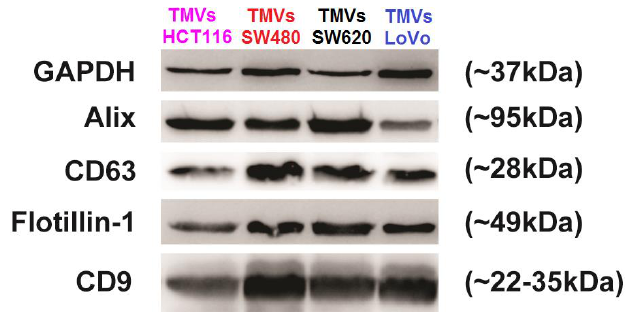
Figure 1. Western blot analysis of GAPDH, Alix, CD63, Flotillin-1, CD9 expression in TMVs collected from HCT116, LoVo, SW480, and SW620 cell lines. A total of 20 µ g of the TMV protein was used for each run. After SDS-PAGE separation and transfer of the proteins onto the polyvinylidene fluoride membranes, the membranes were stained with mouse anti-Alix (3A9), rabbit anti-CD9 (D801A), anti-Flotillin-1 (D2V7J) mAbs, and rabbit polyclonal anti-CD63 Abs. As a loading control, rabbit anti-GAPDH Abs were used. Appropriate secondary Abs: goat anti-mouse and goat anti-rabbit conjugated with horseradish peroxidase, followed by SuperSignal West Pico Chemiluminescence Substrate Kit were used to visualize corresponding protein bands.